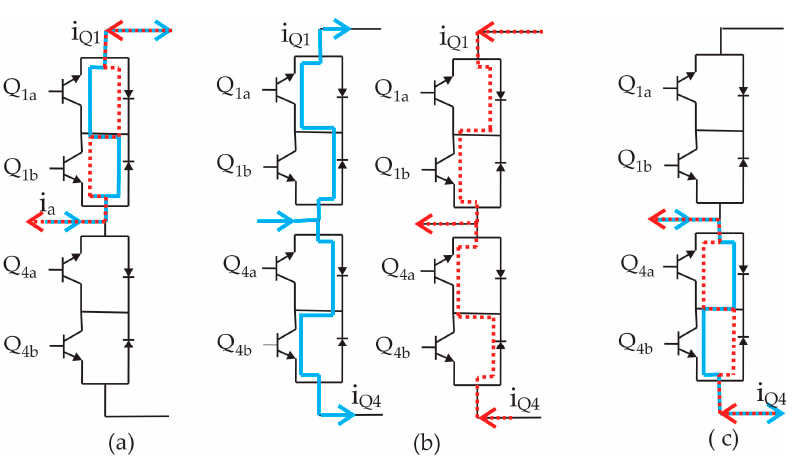
Figure 8. Switching sequence in the on-to-off transition from neutral-to-active switching state. ( a ) initial current flow; ( b ) overlap time; ( c ) current flow in the opposite direction.